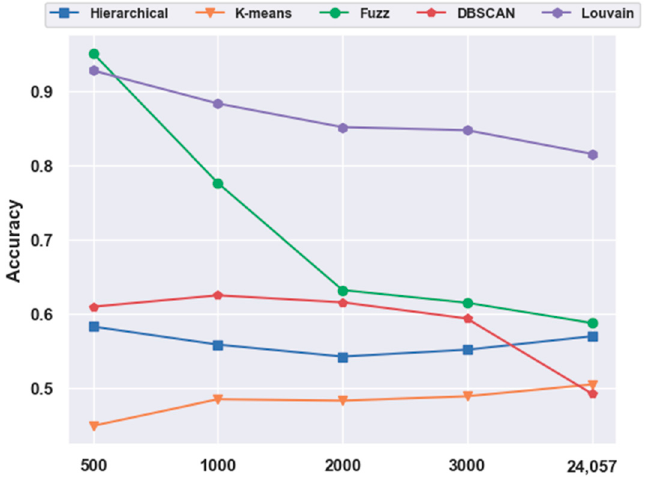
Figure 7. E ff ectiveness of gene selection on mouse visual cortex data. Figure 7. Effectiveness of gene selection on mouse visual cortex data.